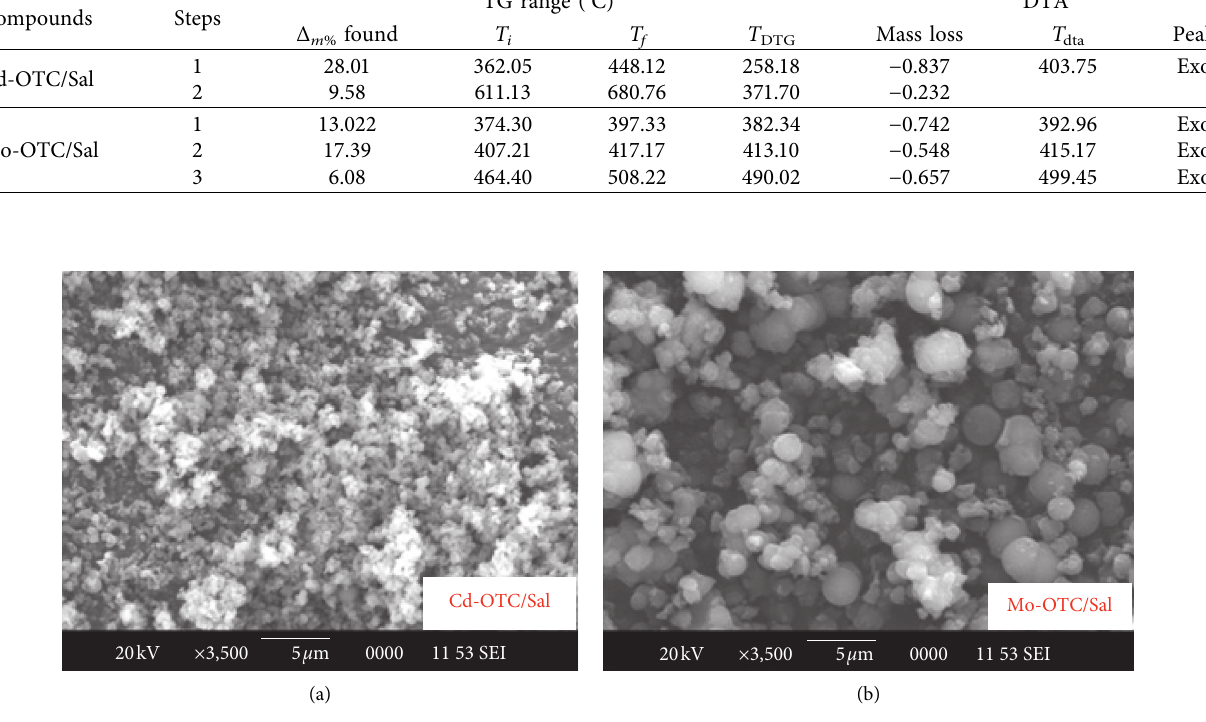
Figure 5: SEM micrograph of the complexes: (a) Cd-OTC/Sal and (b) Mo-OTC/Sal.